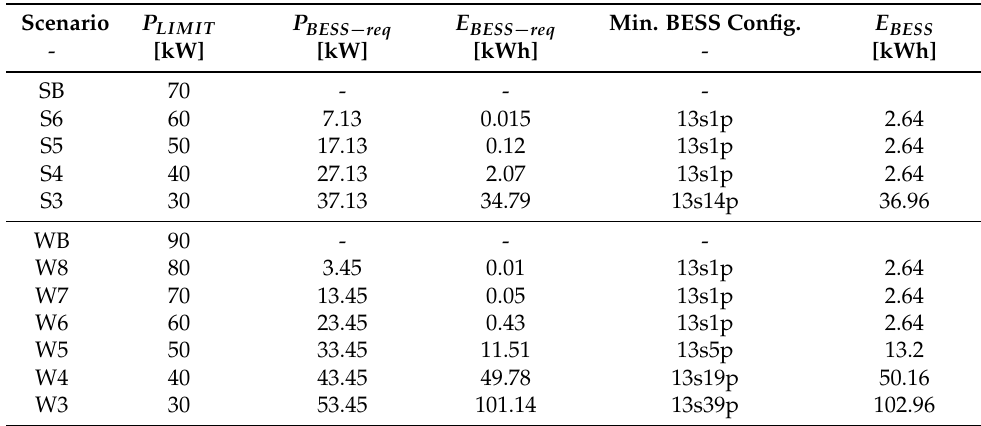
Table 4. BESS requirements for the different